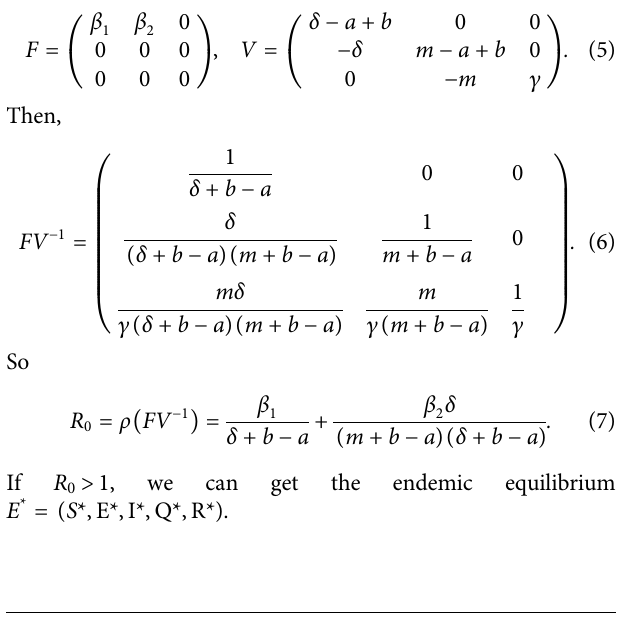
TABLE 1 | The migration relationship between Guangdong Province and Hunan Province.